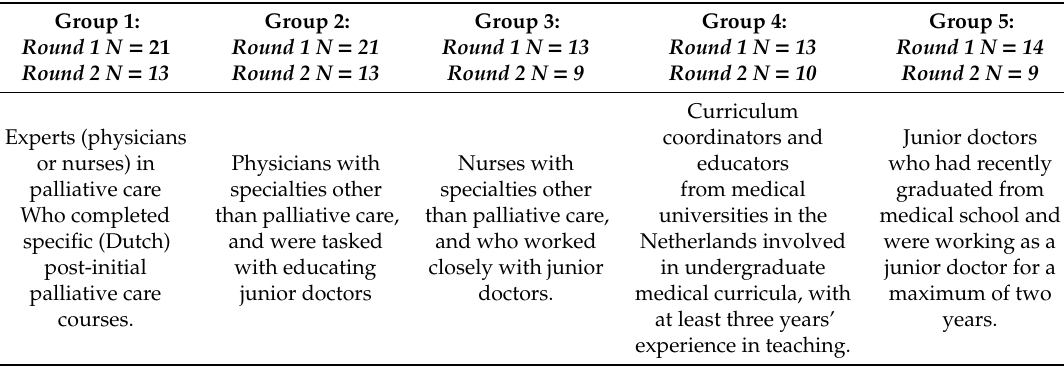
Table 1. The five groups of participating